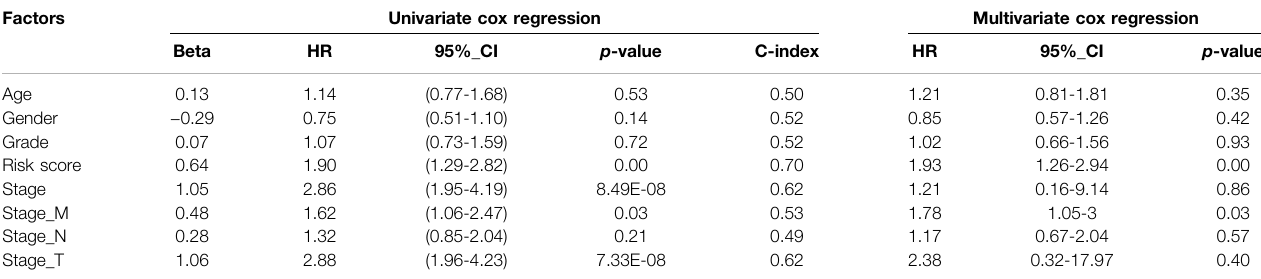
TABLE 1 | Univariate and Multivariate Cox regression analysis of AFs-derived risk score and clinical factors in TCGA-LIHC cohort. Factors Univariate cox regression Multivariate cox regression Beta HR 95%_CI HR Age